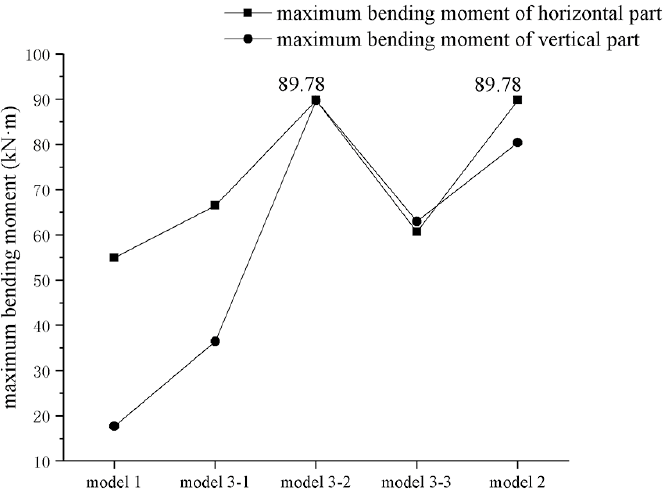
Figure 22. Bending moments of the horizontal part and vertical part for the T-shaped components in each model.